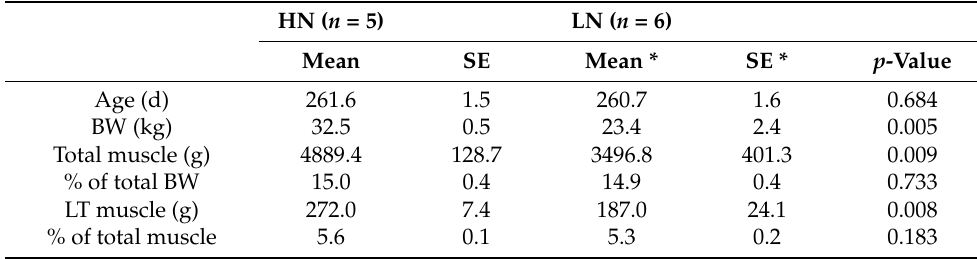
Table 1. Phenotypic effect of maternal nutrient restriction on fetal